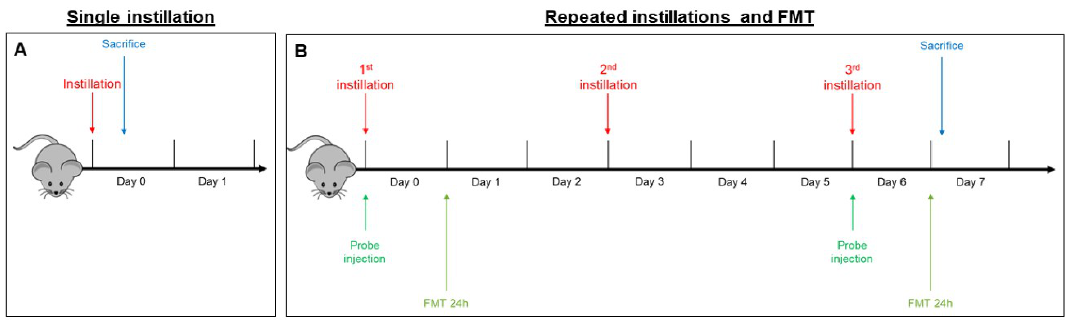
Figure 6. Schematic representation of BALB / c mice acute ( A ) and sub-acute ( B ) treatment and fluorescence molecular tomography (FMT).